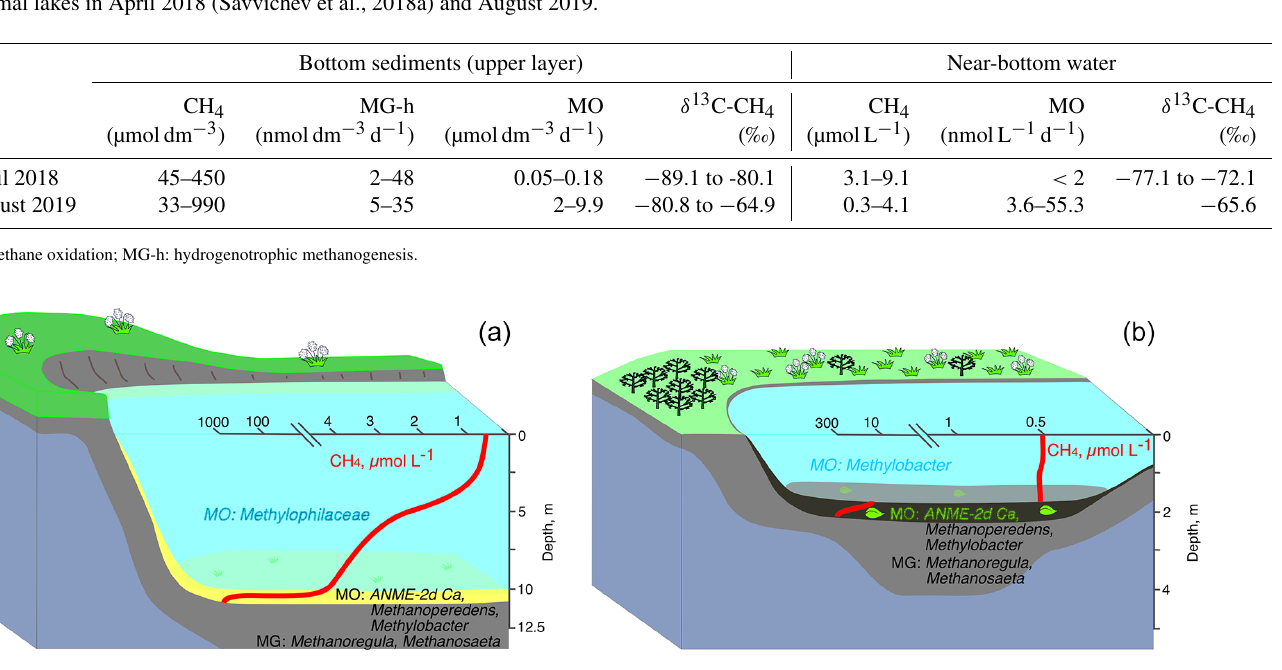
Figure 9. Microbial processes and microbial communities of the methane cycle in the water columns and bottom sediments of deep (a) and shallow tundra lakes (b) of the Yamal